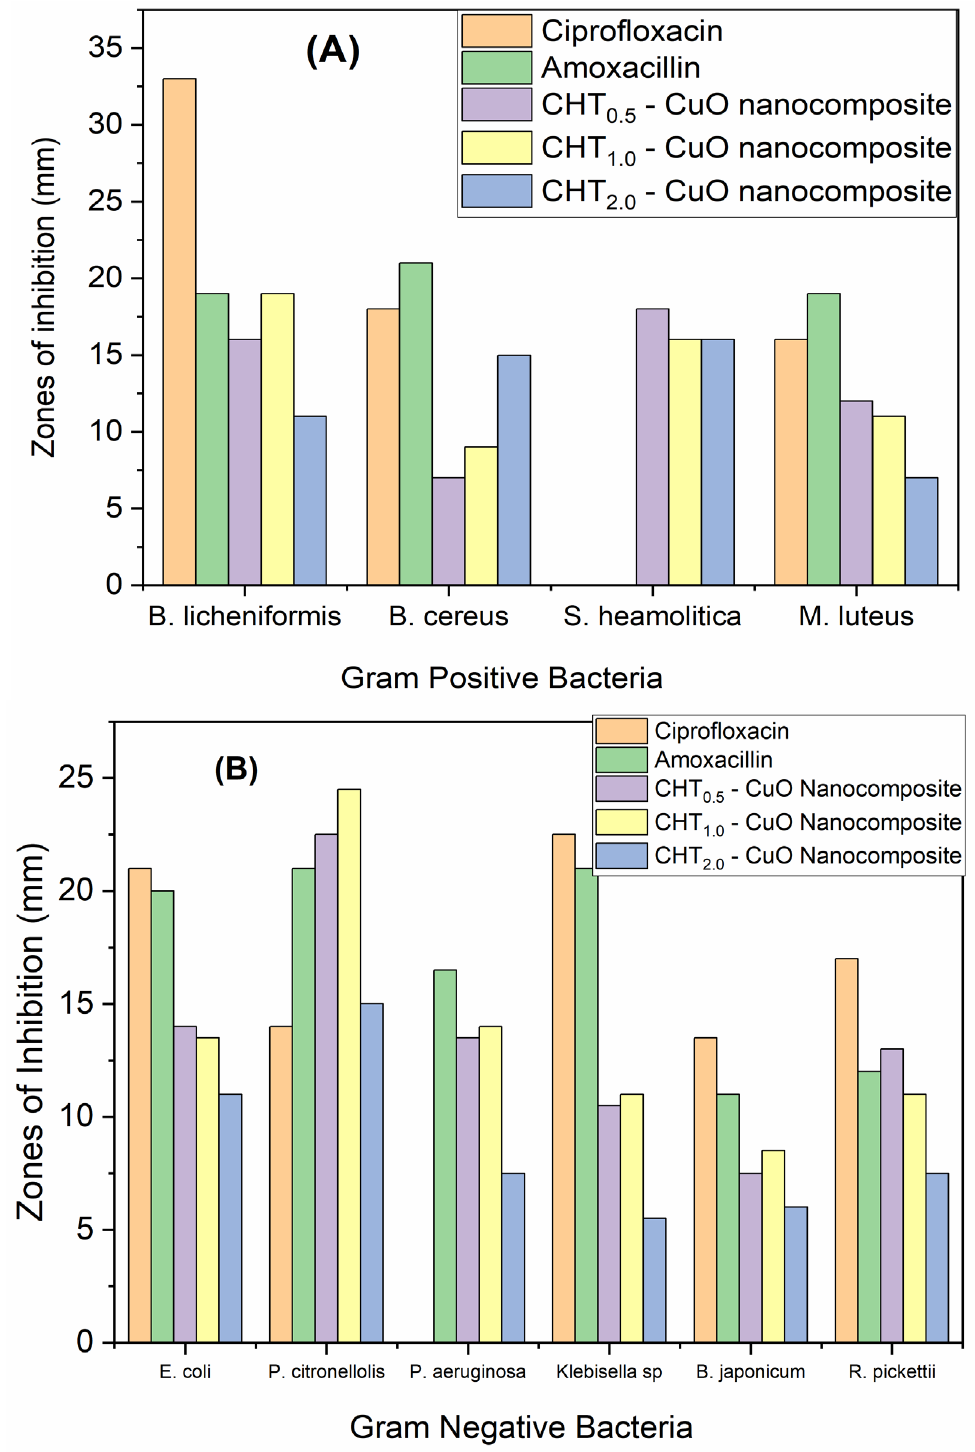
Figure 9. Zones of inhibition showing antibacterial activity of the chitosan-CuO nanocomposite in comparison with antibiotics (ciprofloxacin and amoxicillin) against ( A ) Gram-positive and ( B ) Gram-negative bacteria.